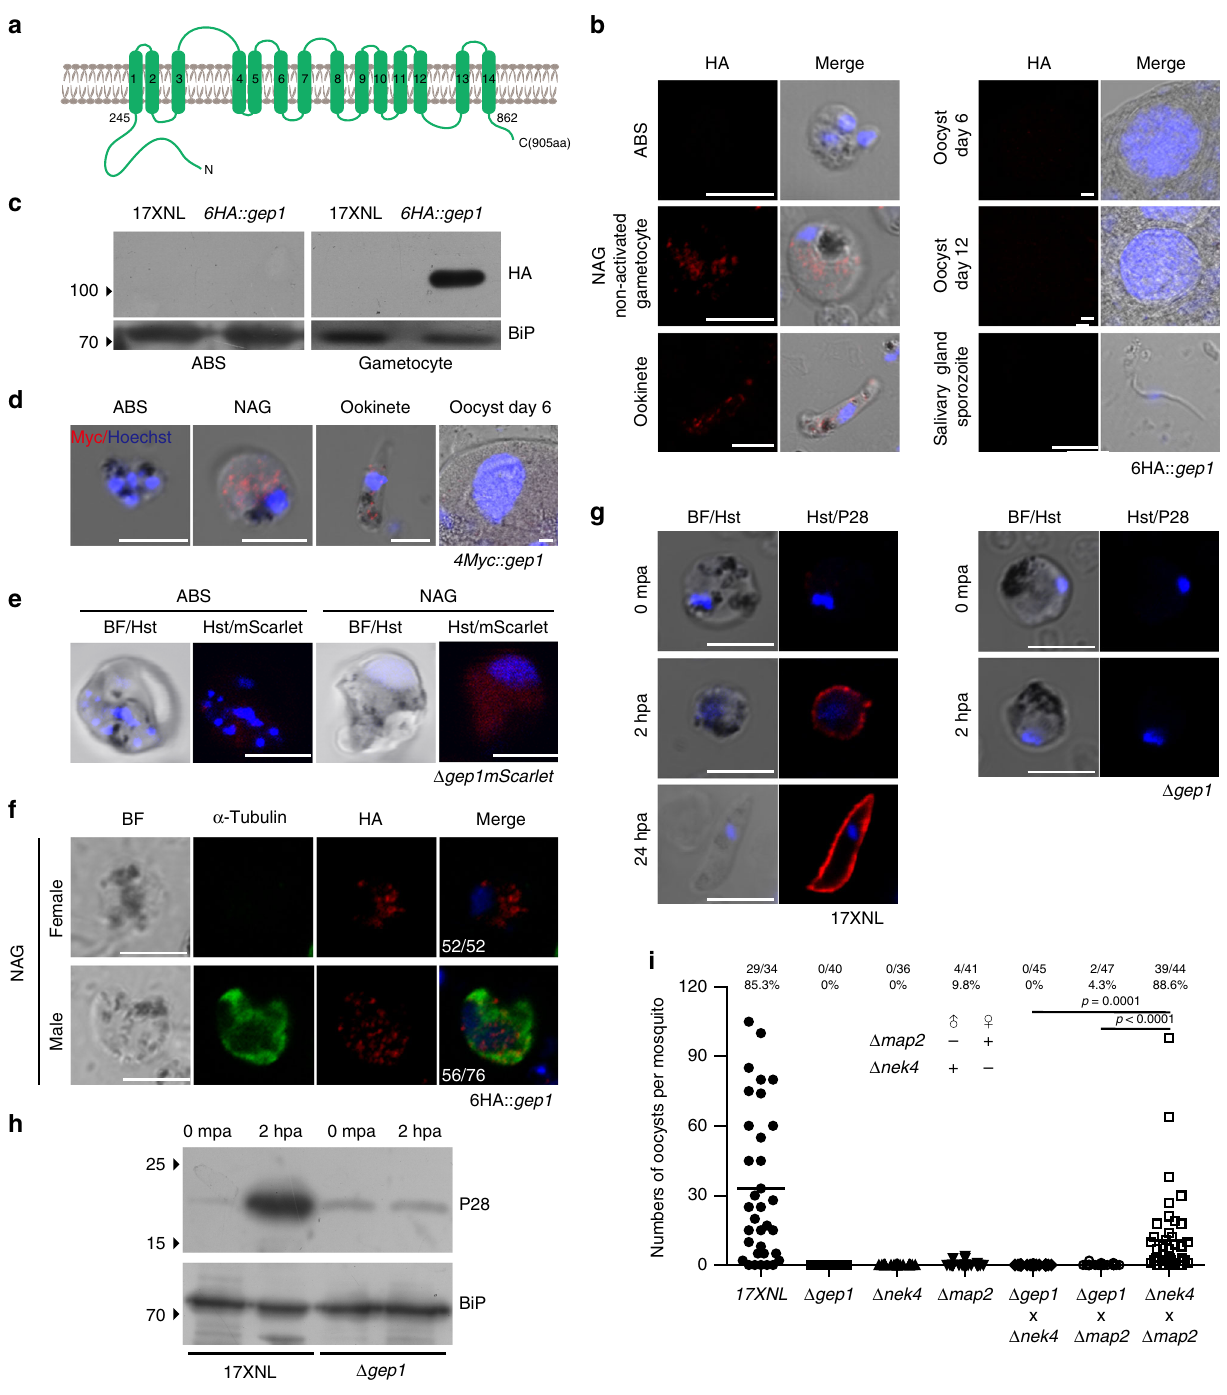
Fig. 2 GEP1 is essential for gametogenesis of both sexes. a Predicted GEP1 protein structure with 14 TM domains (green bar) and cytoplasmic N-termini and C-termini. b IFA analysis of GEP1 expression in asexual blood stages (ABS), gametocytes, ookinetes, oocysts, and sporozoites of the 6HA::gep1 parasite using anti-HA antibody. Hoechst 33342 (Blue) is used for nuclear acid stain for all images in this fi gure. c Western blot analysis of GEP1 in ABS and gametocytes of the 6HA::gep1 parasite. BiP as loading control. d IFA analysis of GEP1 in the 4Myc::gep1 parasite using anti-Myc antibody. e mScarlet fl uorescence protein expression driven by the endogenous gep1 promoter in ABS and gametocytes of the Δ gep1mScarlet parasite. f Co-staining of GEP1 and α -Tubulin (male gametocyte speci fi c) in the non-activated (NAG) 6HA :: gep1 gametocytes. x / y in the fi gure is the number of cell displaying signal/the number of cell tested. g and h , P28 expression during in vitro gametocyte to ookinete differentiation. P28 expression is detected in female gametes, fertilized zygotes, and ookinetes in IFA ( g ) and western blot ( h ). mpa: minute post activation; hpa, hour post activation. i Day 7 midgut oocyst counts from mosquitoes infected with parasites, including 17XNL, Δ gep1 , Δ nek4 , or Δ map2 parasite alone, as well as mixtures of Δ gep1/ Δ nek 4, Δ gep1/ Δ map 2, or Δ map 2 / Δ nek 4 parasites. Δ nek 4 and Δ map 2 are female and male gamete-defect parasites, respectively. x / y on the top is the number of mosquito containing oocyst/the number of mosquito dissected; Mosquito infection prevalence is shown above. Scale bar = 5 μ m for all images in this fi gure. Experiments were independently repeated three times in b , c , d , e , f , g , and two times in i . Two-tailed unpaired Student ’ s t test in i